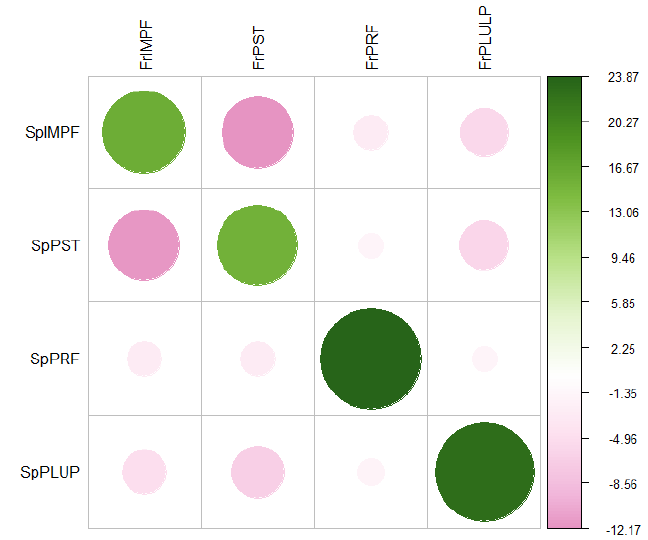
Figure 3. Visualization of Pearson residuals of Spanish tenses translated to French tenses in narration.